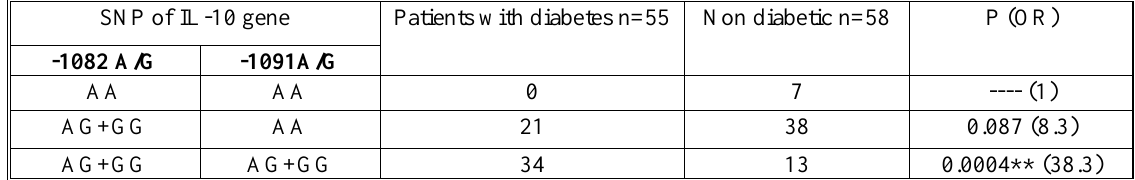
Table 3. The interaction between two single nucleotide polymorphisms (SNPs) of the interleukin 10 (IL-10) gene at positions -1082 A/G and 1091 A/G in type 2 diabetes mellitus and non-diabetic subjects. SNP of IL-10